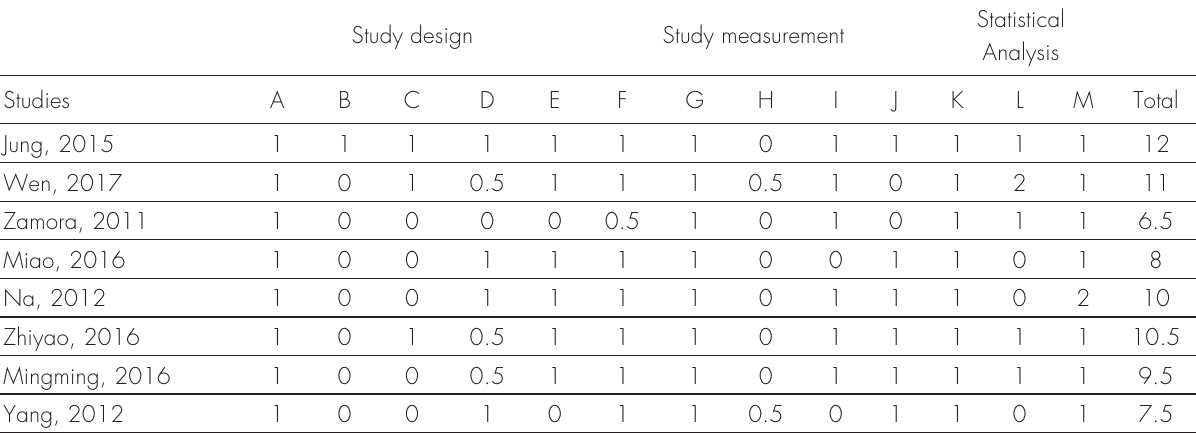
Table V. Quality assessment of the included studies using the QUAMAS tool. Study design Study measurement